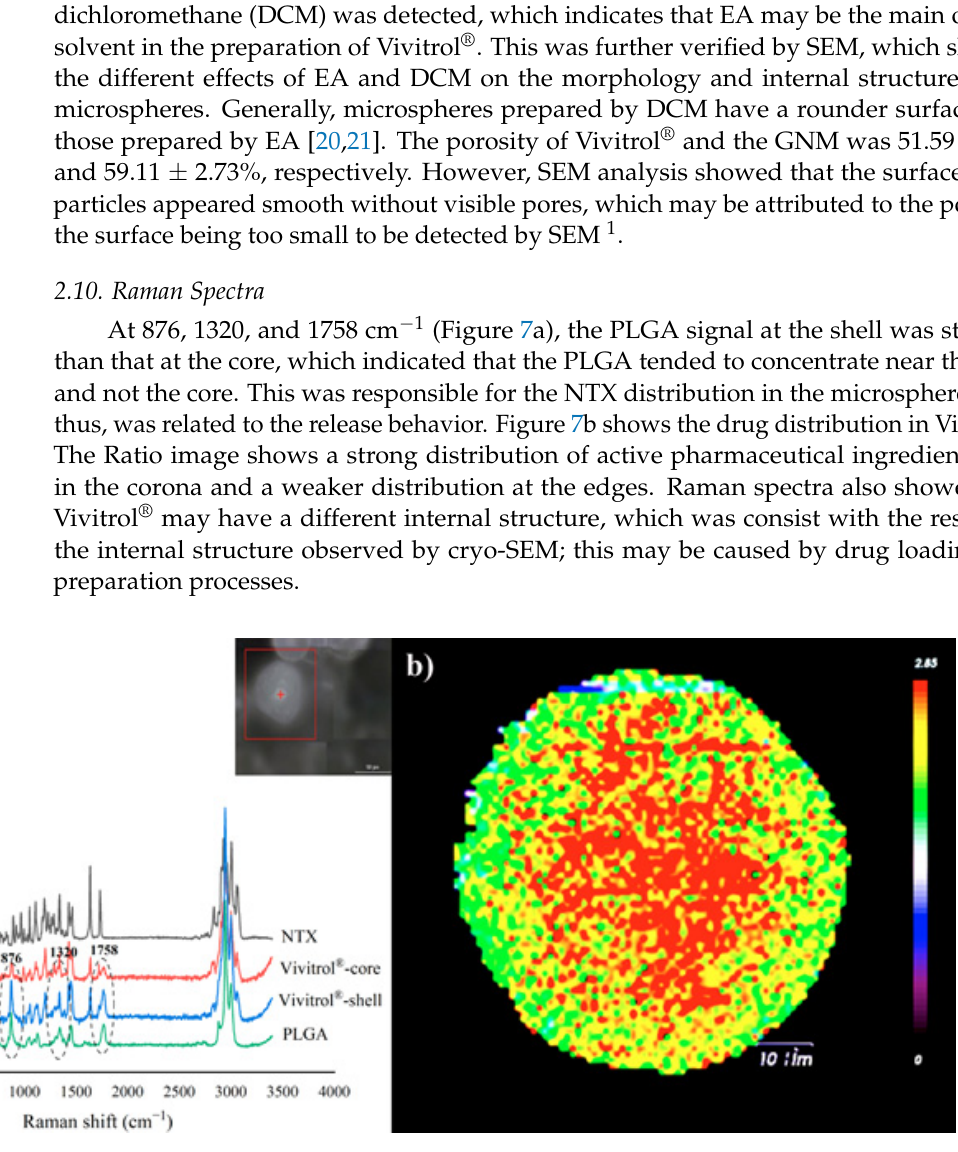
Figure 7. ( a ): Raman shift of NTX, Vivitrol ® (core and shell) and PLGA, ( b ): Drug distribution image in Vivitrol ®.